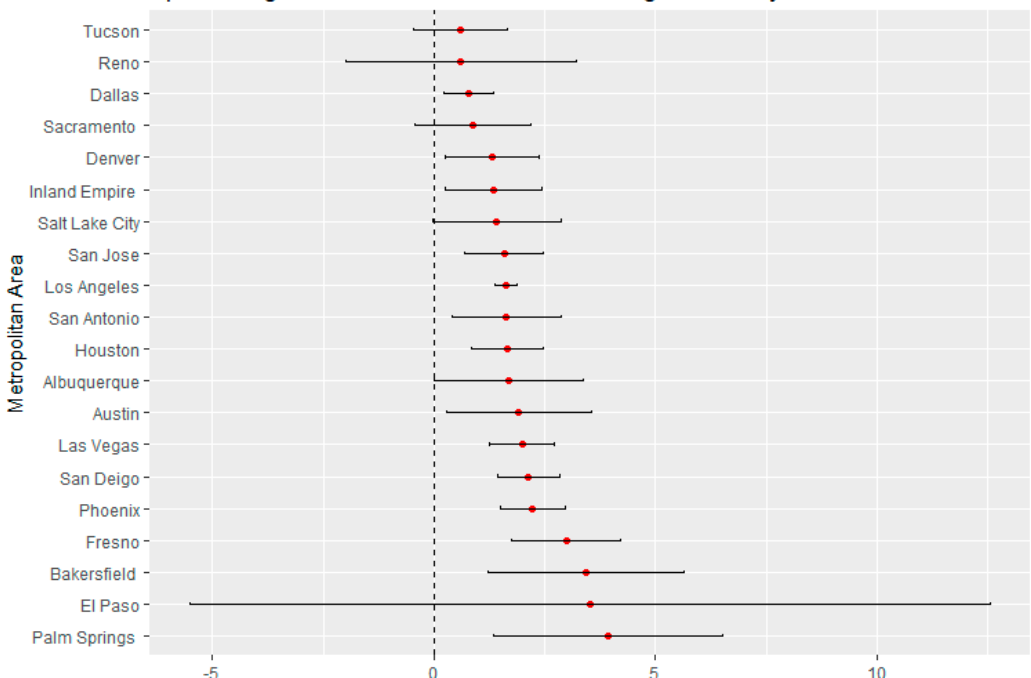
Figure 6. Spatial regression coefficients for median income during an extreme heat day in 20 Southwest metropolitan areas.